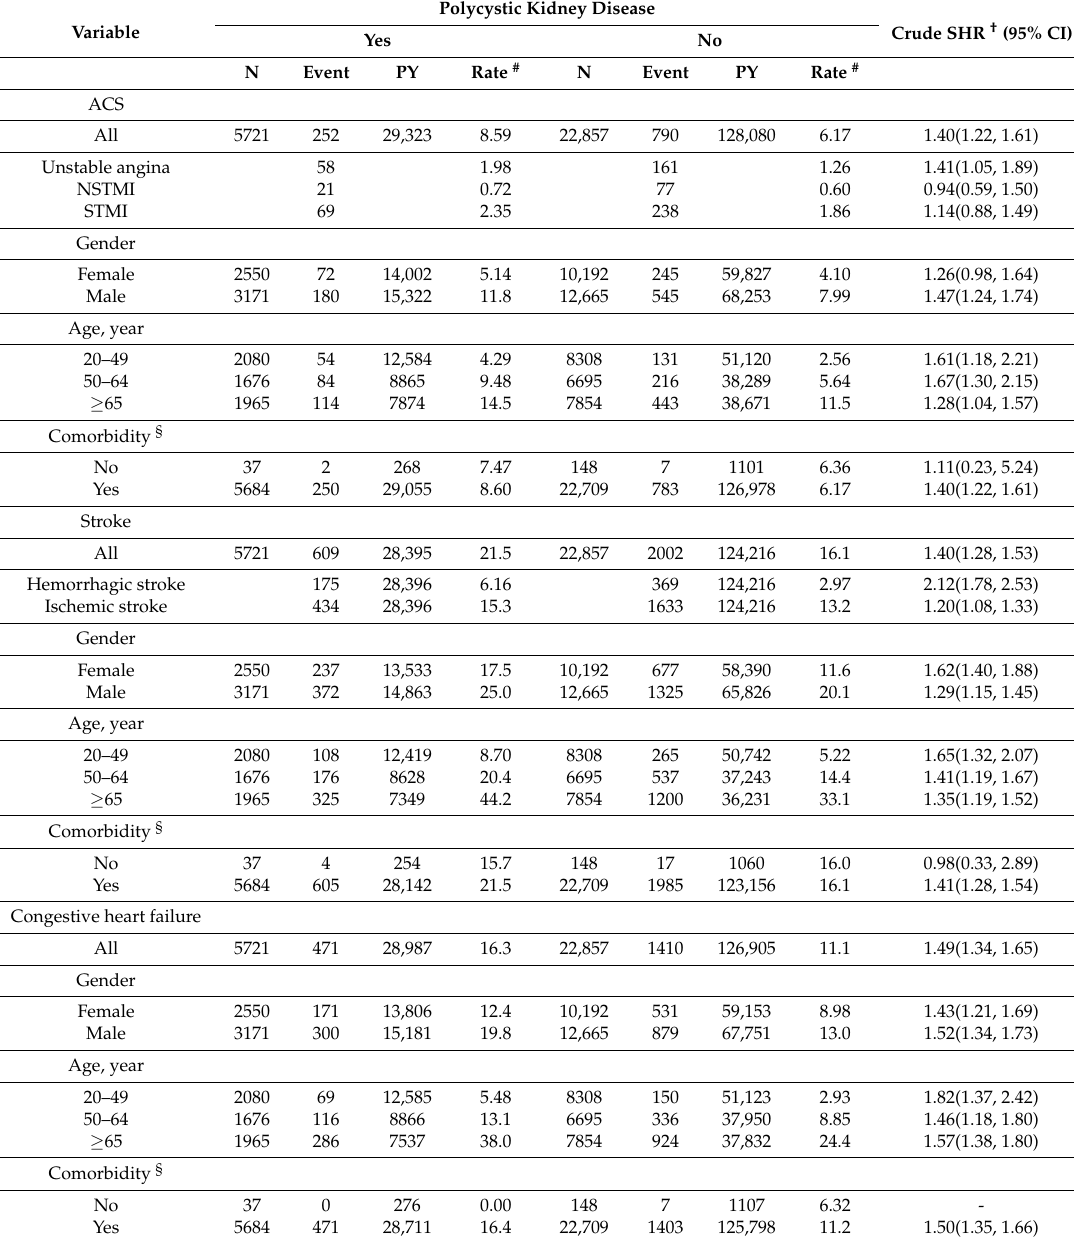
Table 2. Incidence and hazard ratio of outcome between patients with and without polycystic kidney